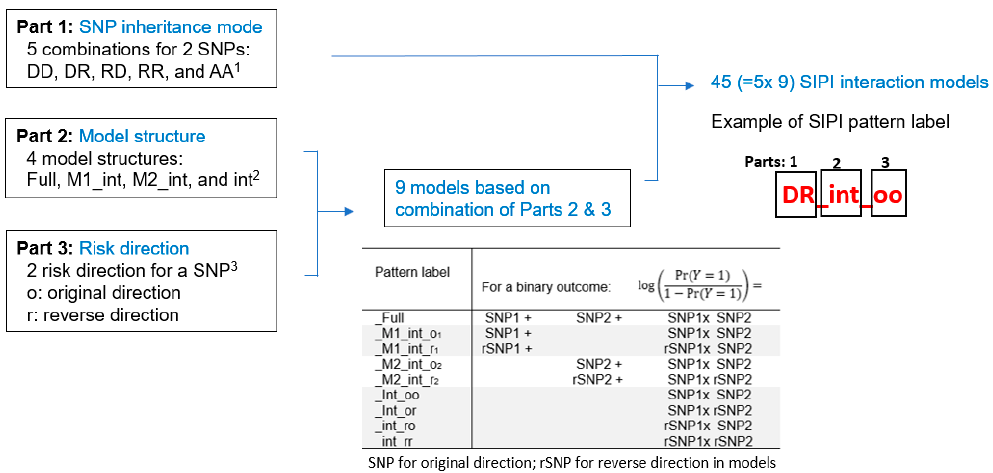
Figure 1. Summary of the 45 SNP–SNP interaction models based on the SNP Interaction Pattern Identifier (SIPI). Note: 1 D: dominant, R: recessive, A: additive inheritance mode. 2 Full: full interac-